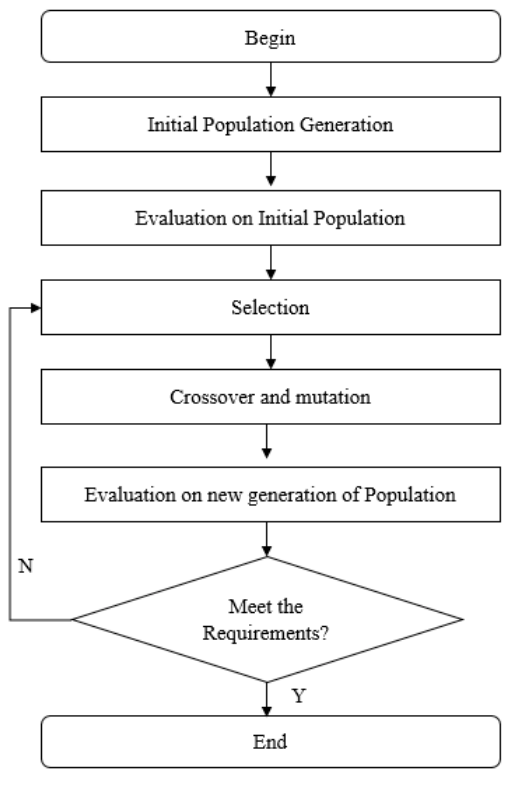
Figure 3. Genetic algorithm flow [15].